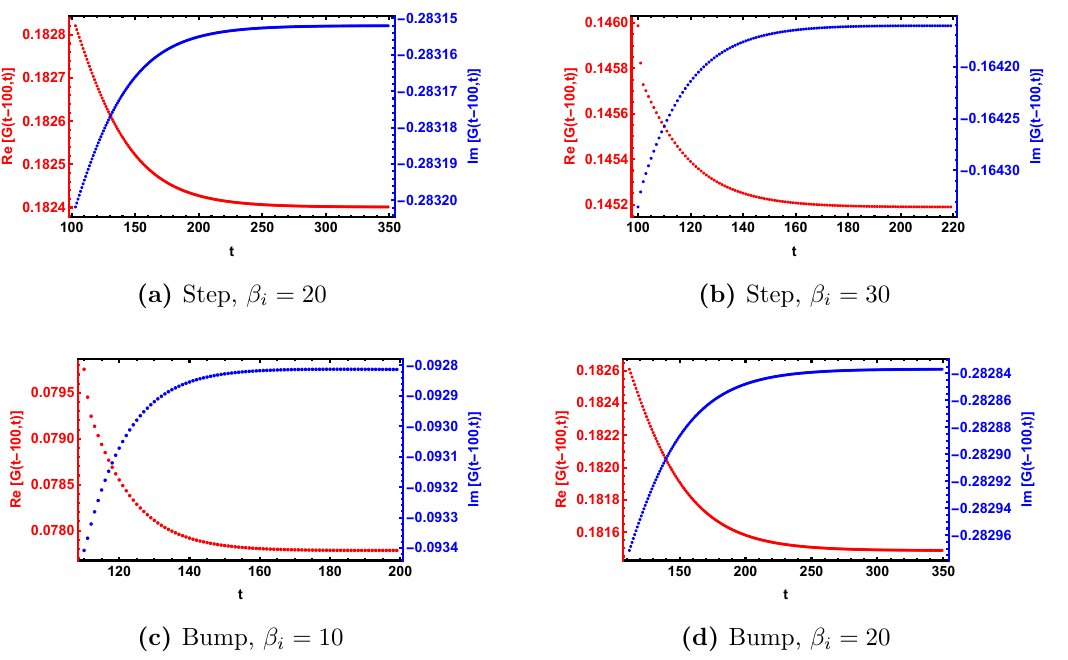
Figure 7. Real and imaginary parts of G > ( t (cid:0) 100 ; t ) for di(cid:11)erent quench protocols. Similarly, for bump quenches in (cid:12)gures 7c, 7d, once the two time arguments are outside the quench region, the Green’s function thermalizes rapidly and its real and imaginary parts (cid:12)t exponential functions very well. Below, we will consider only the exponent for the imaginary part which we will denote by (cid:13) Itt